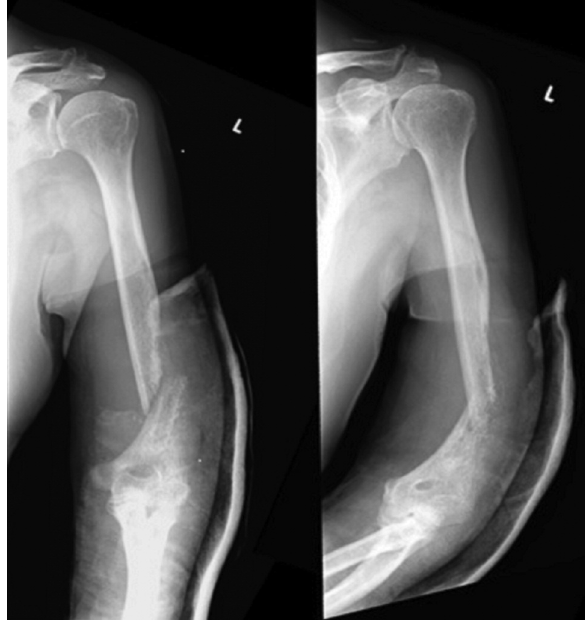
Diaphyseal fracture at the distal humerus shaft, with Fig. 1: cortical thickening and a moth-eaten appearance suggestive of a pathological fracture.